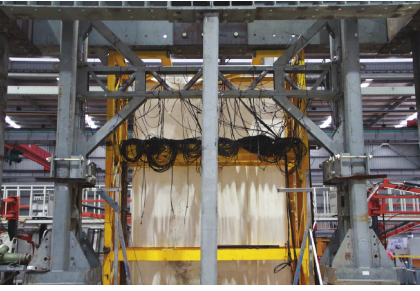
Figure 16: Test setup.